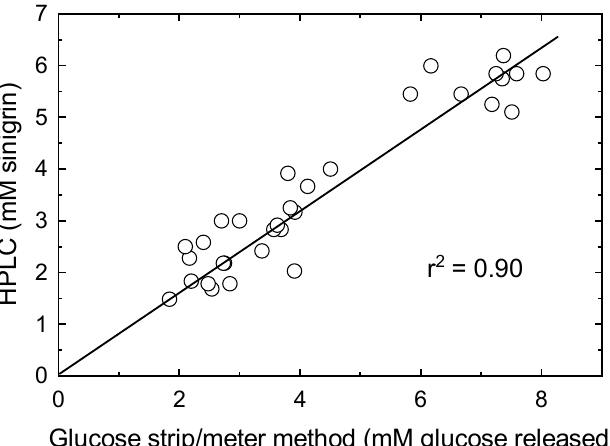
Fig. 5: Correlation between the amount of sinigrin determined by HPLC and glucose released from the same samples using the ‘ITC quick test’ developed